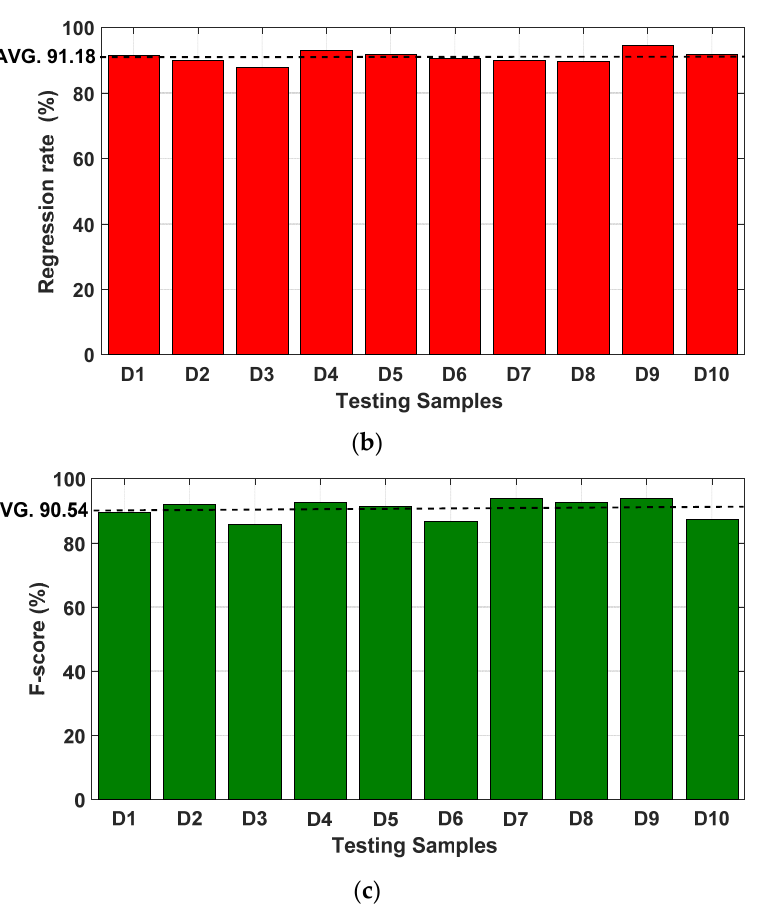
Figure 26. The training process comparison based on the damage identification test data for ten data sets of displacement. ( a ) Accuracy ( 𝑃% ). ( b ) Regression rate ( 𝑅% ). ( c ) F1-score ( 𝐹% ).